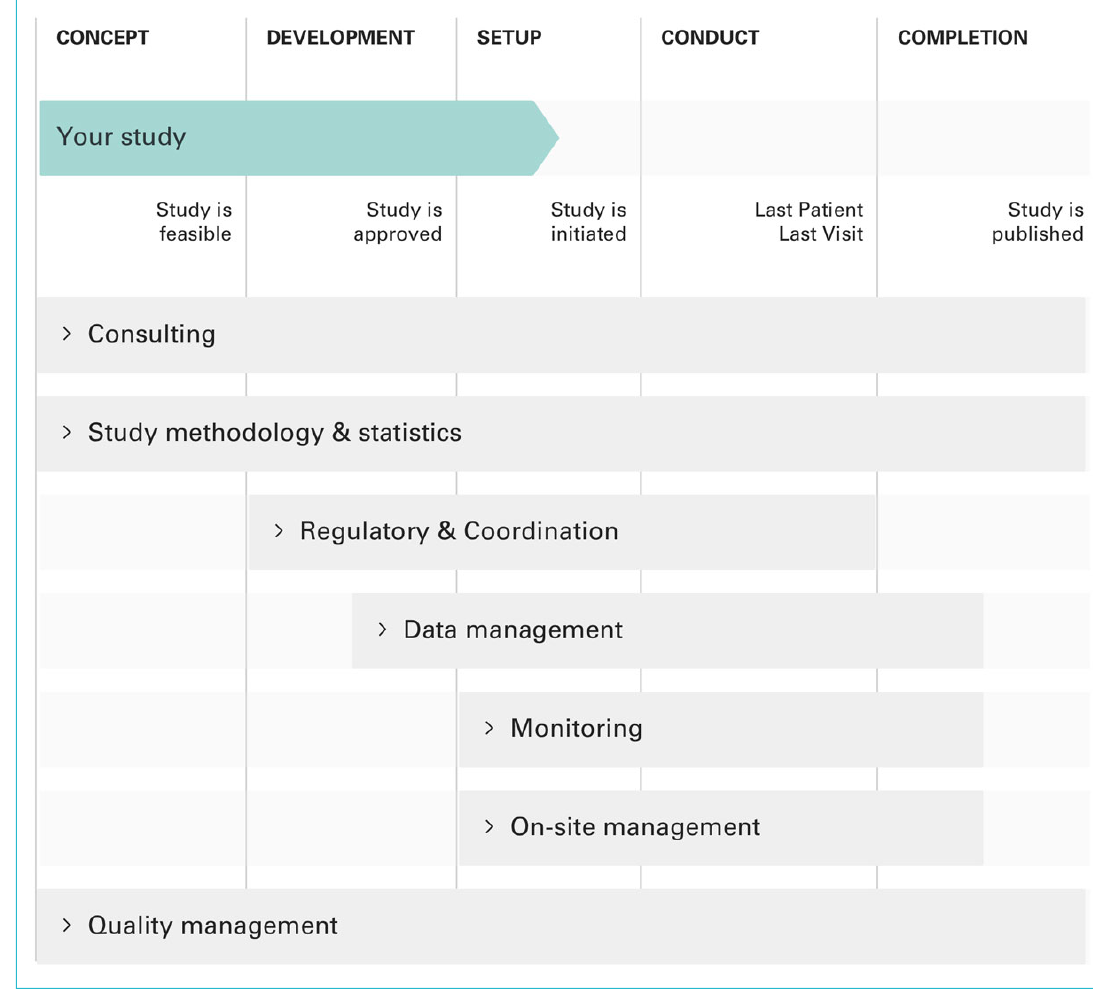
Figure 1: The CTU services apply through all stages of a